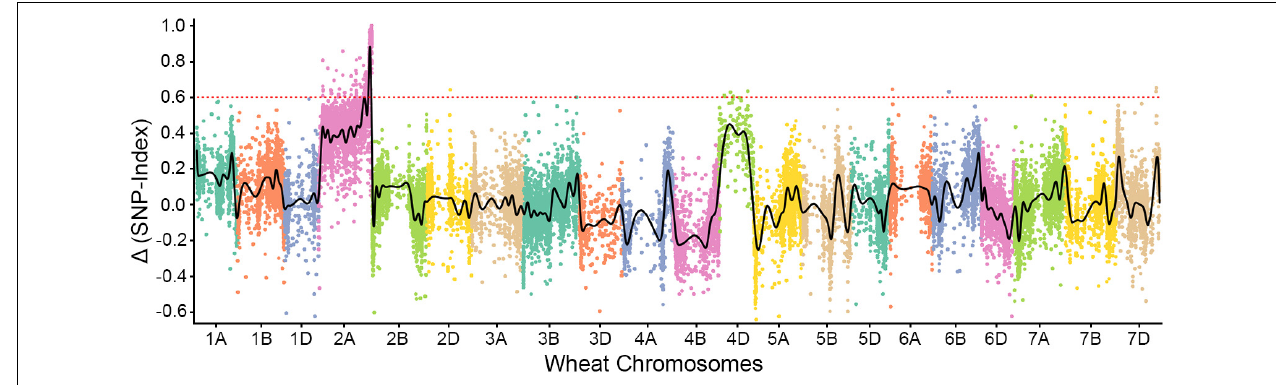
FIGURE 2 | Bulked segregant RNA-Seq (BSR-Seq) analysis of Pm SN 15218 . Pm SN 15218 was localized at the distal end of the long arm of chromosome 2A. TABLE 2 | Markers developed in this